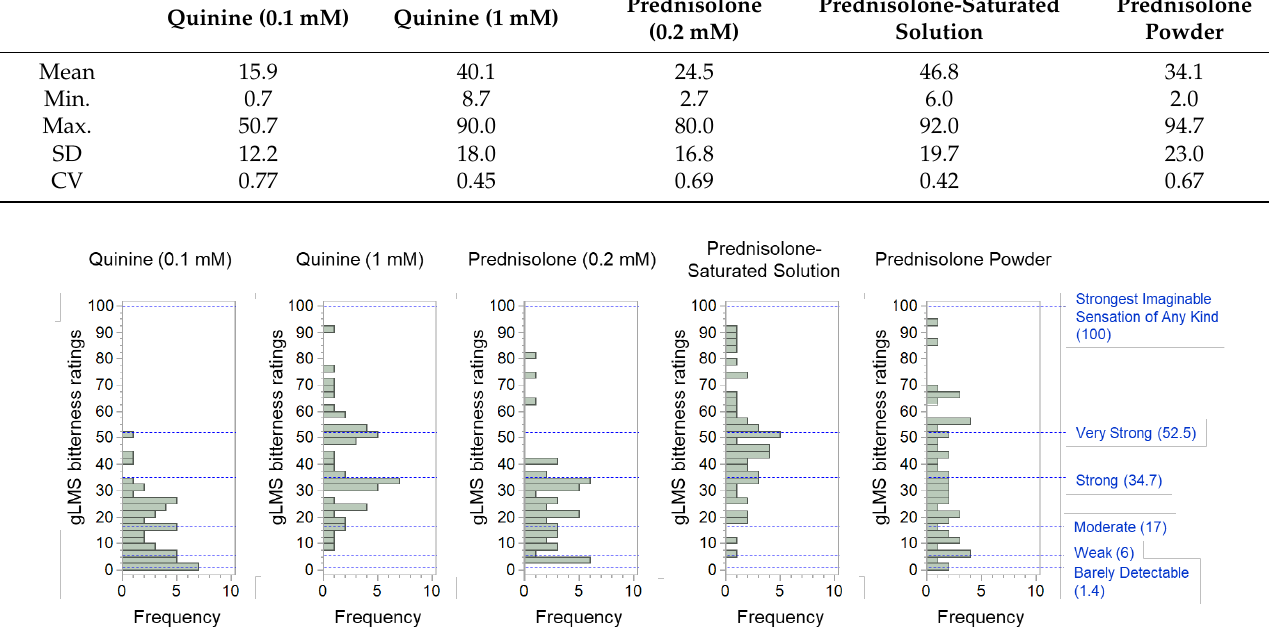
Figure 1. Histograms of the gLMS bitterness ratings by subjects ( n = 50) for each stimulus.